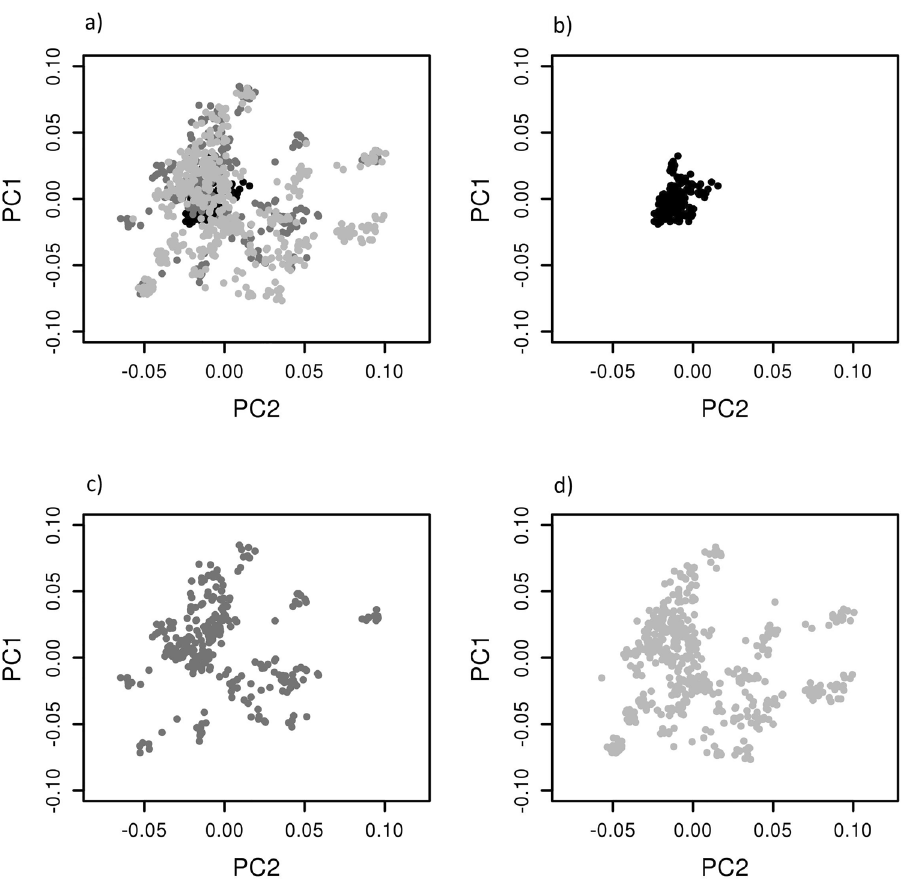
Figure 3. Population structure represented by the first and second components of the marker-based relationship matrix spectral decomposition: ( a ) across all population; ( b ) POP1HD population; ( c ) POP1GF population and ( d ) POP2GF